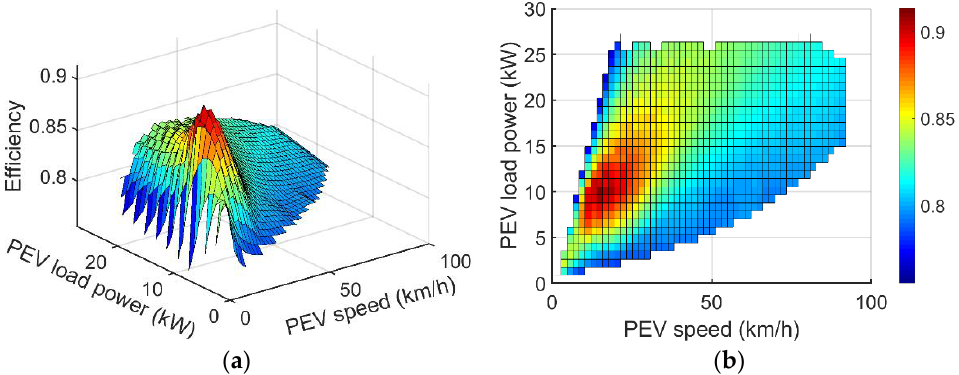
Figure 8. Vehicle characteristics of working mode 2 under original parameters. ( a ) MAP of efficiency characteristic; ( b ) working area and corresponding efficiency.